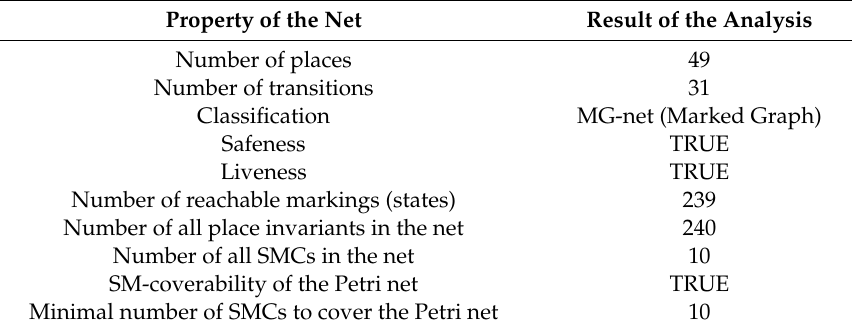
Table 2. Results of analysis of the Petri net from Figure